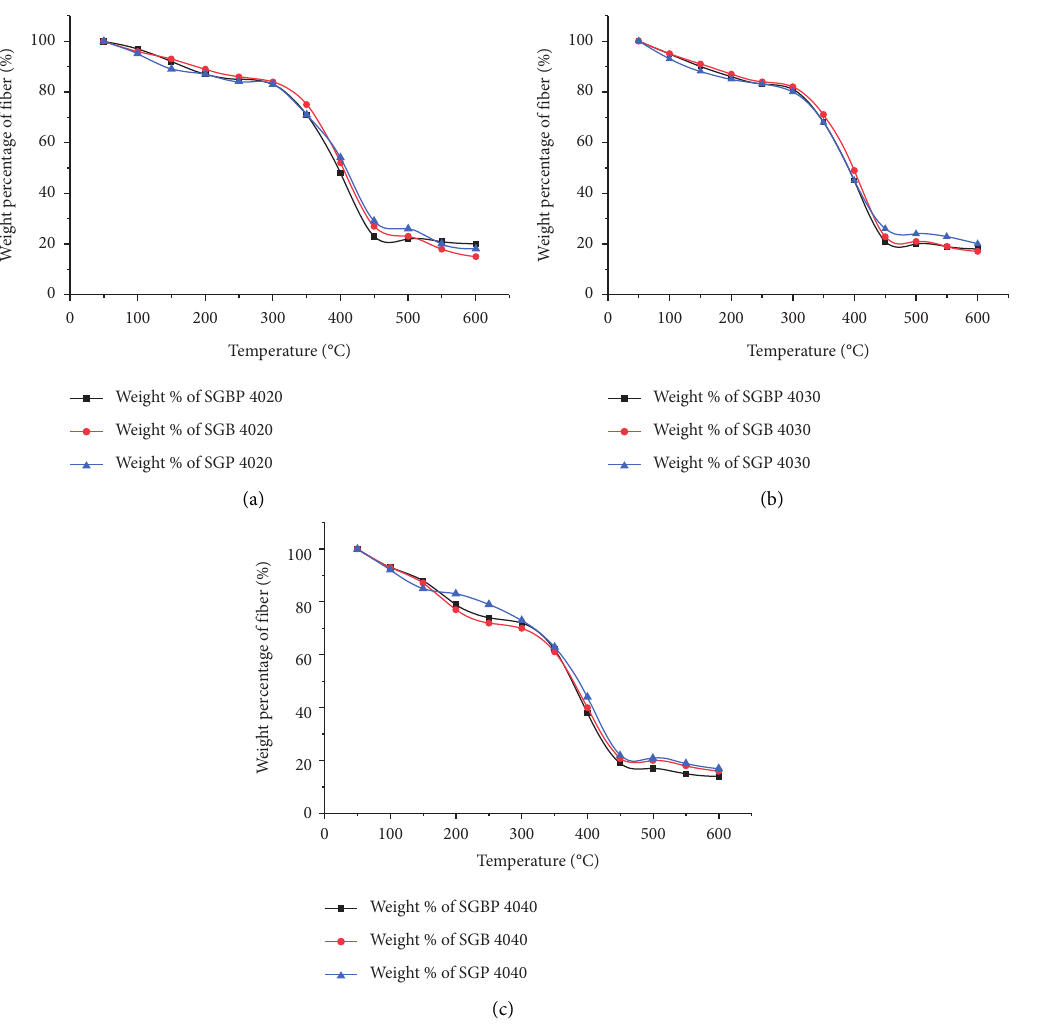
Figure 5: Graphical representation of weight percentage of 40% fiber volume sample at (a) 20cm fiber length, (b) 30cm fiber length, and (c) 40cm fiber